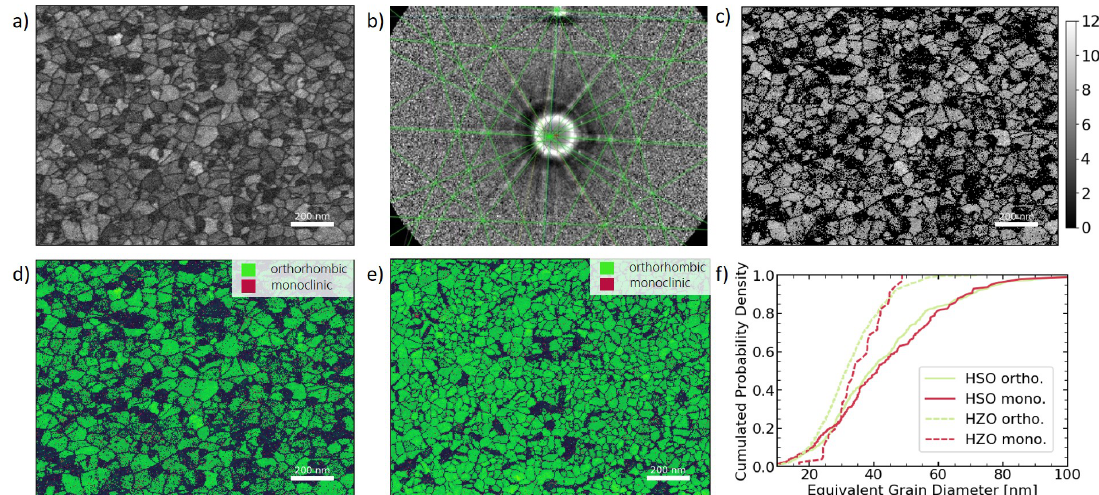
Figure 2. Transmission Kikuchi diffraction analysis of HSO and HZO layers. ( a ) shows the quality map extracted from the scatter signal of HSO film. The measured Kikuchi patterns (here shown for HZO) are fitted with given phases, shown for orthorhombic phase in ( b ) and the reliability of the fit can be estimated from the number of indexed lines, which is visualized in ( c ) for HSO. The assigned phases can be shown in so-called phase maps, shown in ( d ) and ( e ) for HSO and HZO, respectively. The extracted equivalent diameter of the grains is displayed in the form of cumulative distributions ( f